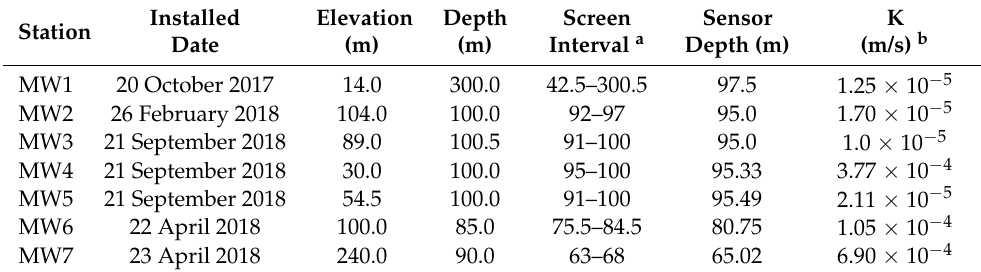
Table 1. Description of groundwater monitoring stations in Korea.